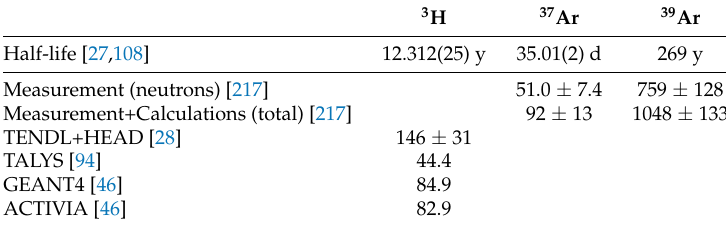
Table 11. Rates of production of long-lived radioisotopes induced in argon at sea level. Measurements from Ref. [217] and different calculations are presented (see text). All numbers are expressed in